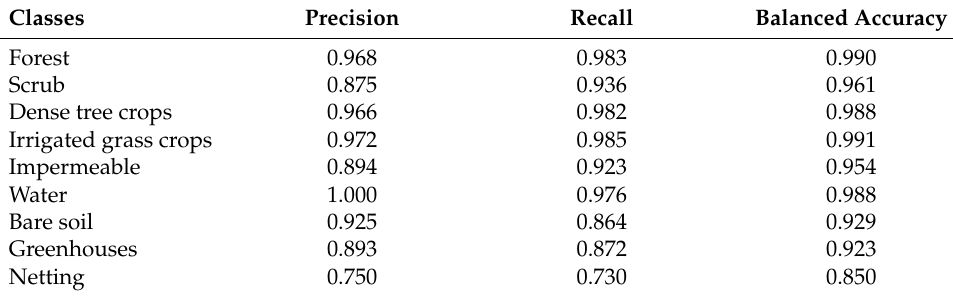
Table 8. Main classification statistics per class.